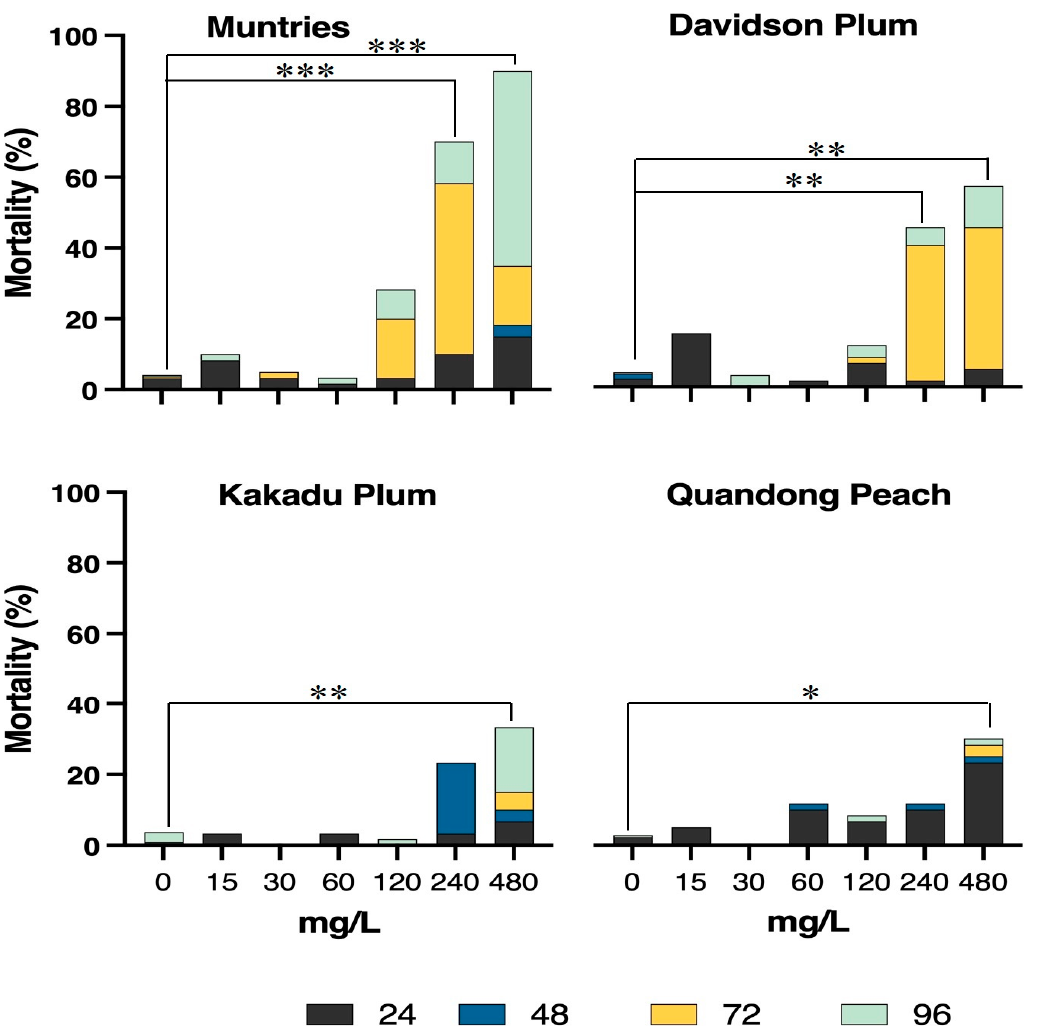
Figure 5. Percentage of mortality observed in zebrafish embryos exposed during 96 h to different concentrations of native Australian fruits. The colors represent the time at which mortality was observed. Significant differences are observed for muntries at 240 and 480 mg/L compared to controls (0), both values represented by *** p < 0.001. Davidson plum: ** p < 0.01 for 240 and 480 mg/L compared to controls (0). Kakadu plum: ** p < 0.01 for 480 mg/L compared to controls (0). Quandong peach: * p ≤ 0.05 at 480 mg/L compared to controls (0).